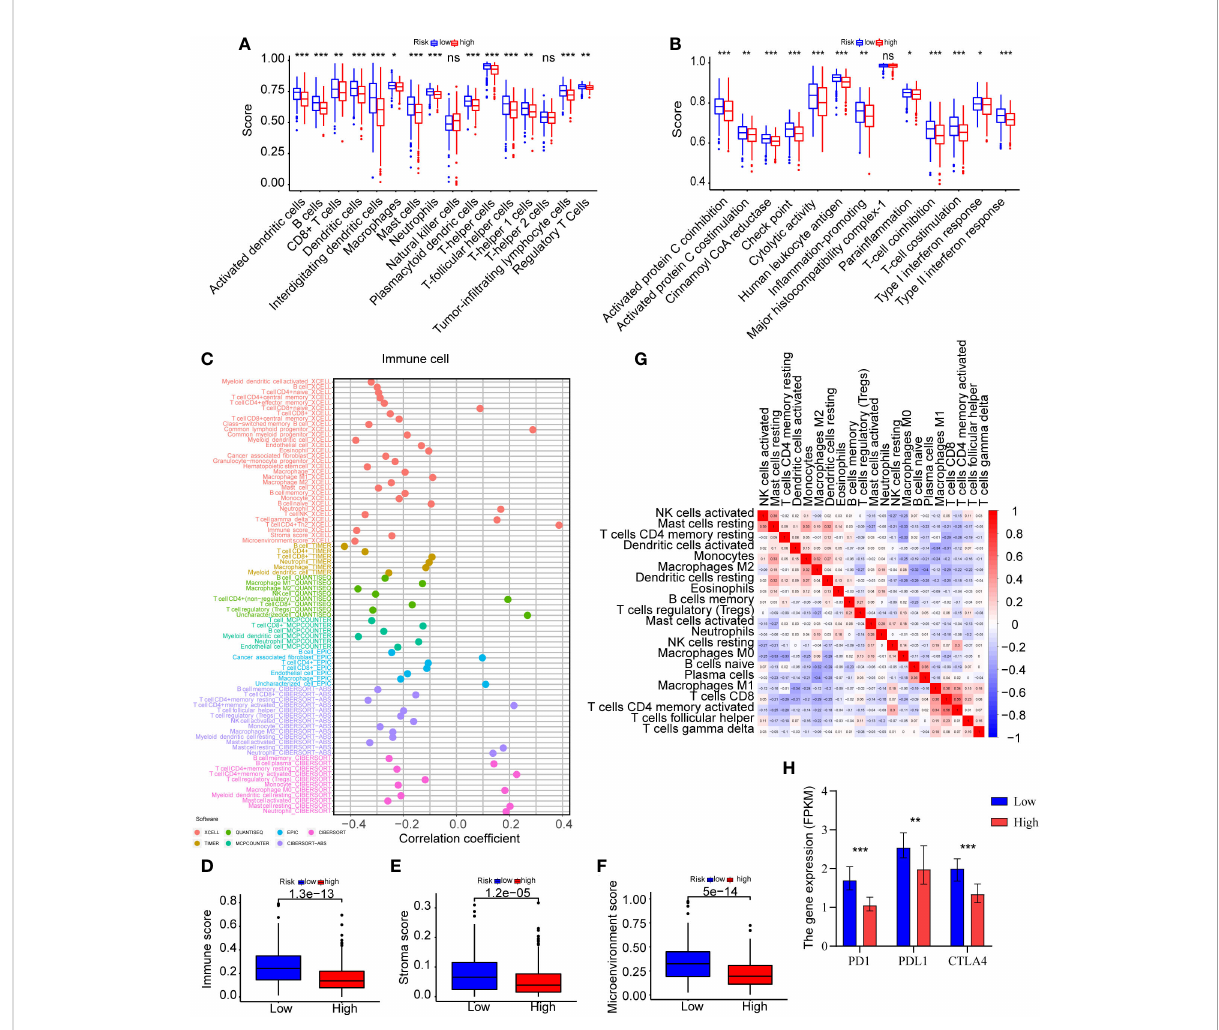
FIGURE 7 Analyses of immune in fi ltration in the high-risk and low-risk categories. (A) ssGSEA was used to undertake the immune cells score between the two groups. (B) The immune cell function analysis among the two groups was explored by ssGSEA. (C) Immune cells expression analysis was performed through various methods, including XCELL, TIMER, QUANTISEQ, MCPCOUNTER, EPIC, CIBERSORT-ABS, and CIBERSORT. (D – F) The immune score, stroma score and microenvironment score were compared between the two risk groups by XCELL. (G) CIBERSORT was used for the association analysis between immune cells. (H) The expression levels of PD-1, PD-L1, and CTLA-4 were compared between the two groups (*P<0.05, **P<0.01, and ***P<0.001).